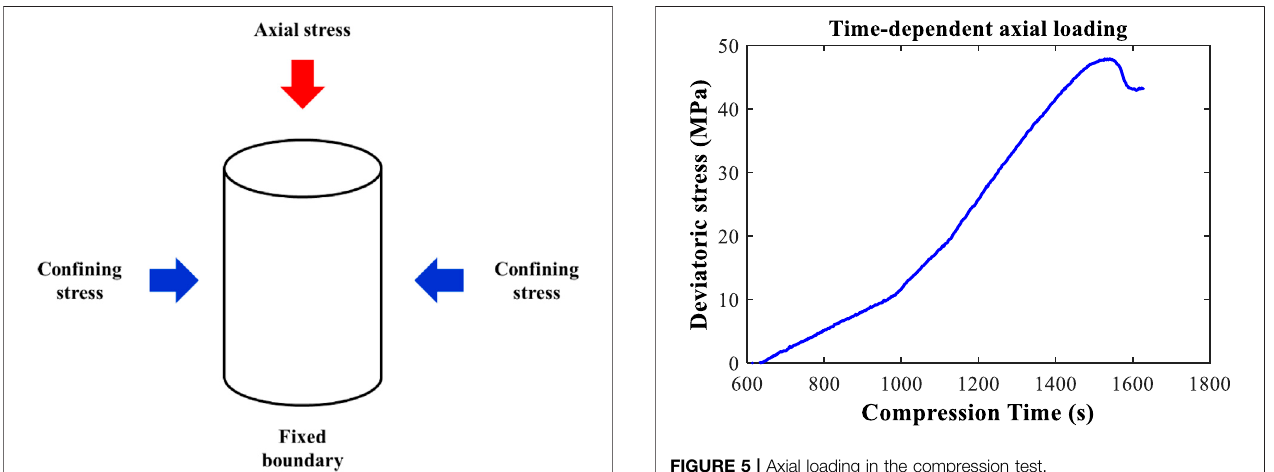
FIGURE 5 | Axial loading in the compression